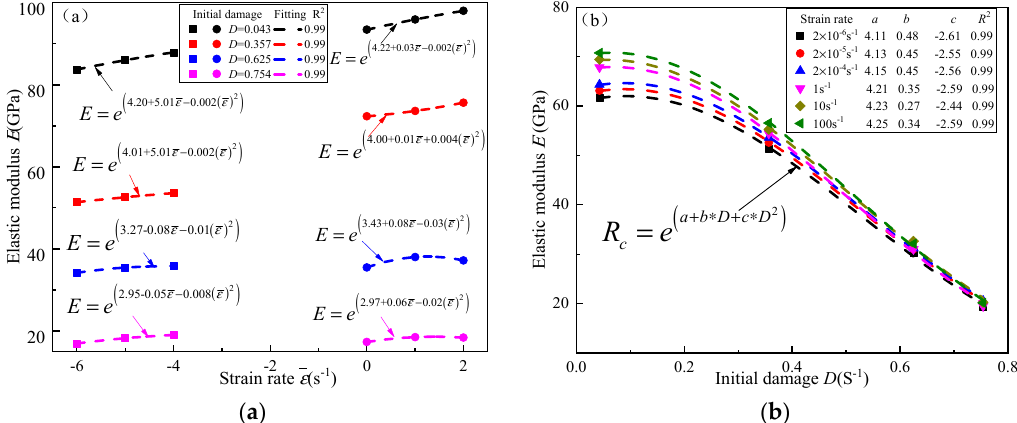
Figure 10. Plot of the elastic modulus versus the initial damage for the axial test from 2 × 10 − 6 s − 1 to 100 s − 1 levels of strain rate: ( a ) E − ; ( b ) E-D .